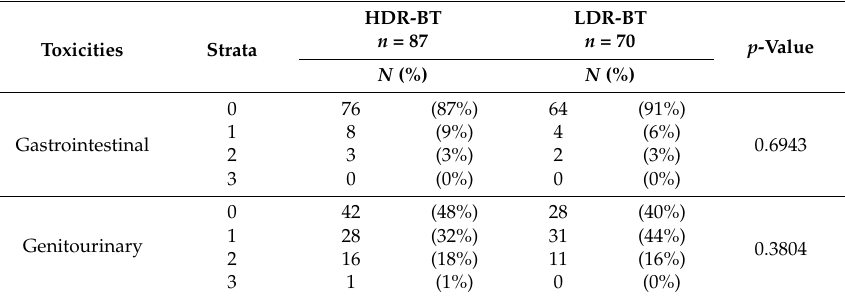
Table 7. Late toxicities according to modalities in